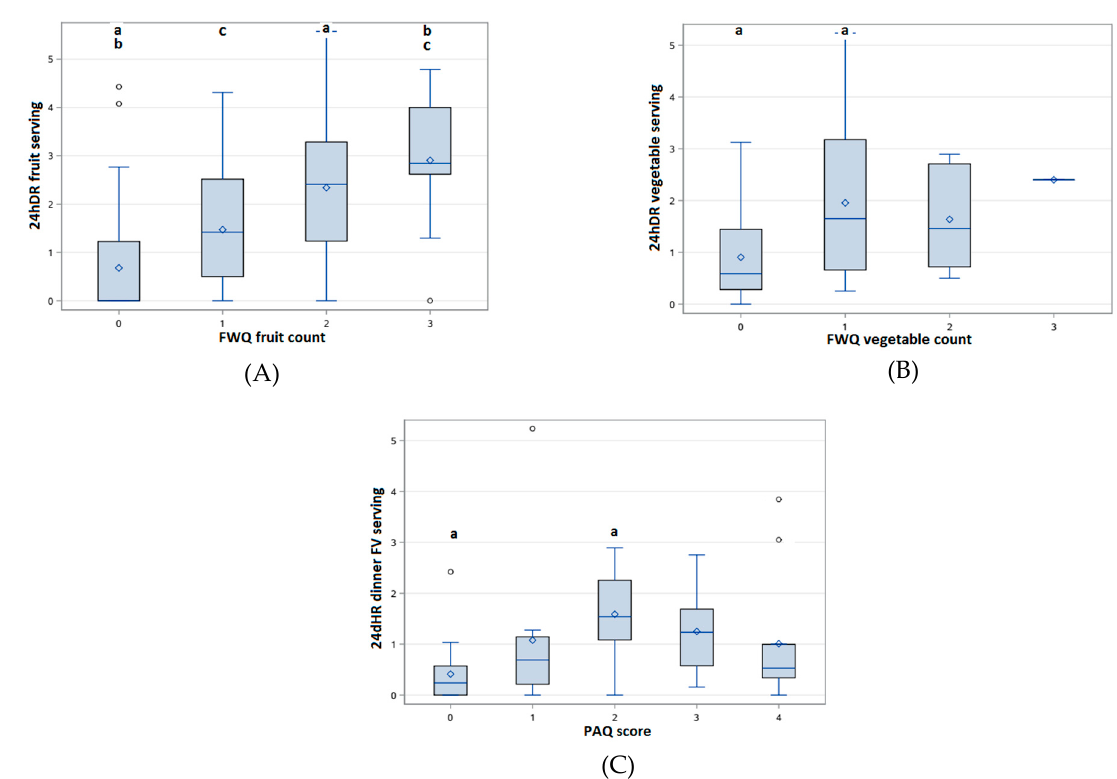
Figure 1. Comparison of participants’ 24hDR fruit and vegetable servings by FWQ and PAQ responses. ( A ): 24hDR fruit servings by FWQ fruit counts; ( B ): 24hDR vegetable servings by FWQ vegetable counts; ( C ): 24hDR fruit and vegetable servings at dinner by PAQ scores. Bars marked with the same letter indicated p < 0.05 in Tukey post hoc tests. FWQ: food web questionnaire; PAQ: plate